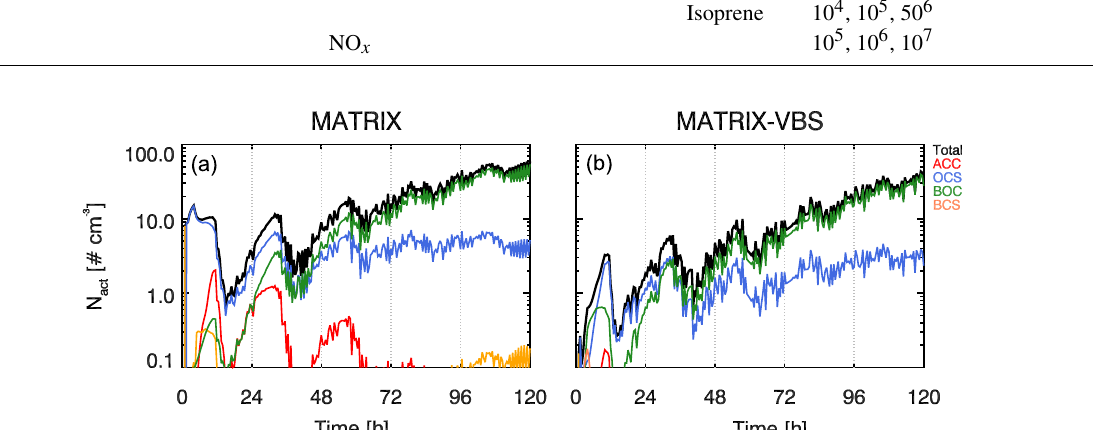
Figure 1. Activated number concentration of aerosol populations (see main text for details) for MATRIX (a) and MATRIX-VBS (b) for 290K and 40% RH at 30 ◦ N latitude with medium emission levels and 0.5ms − 1 updraft